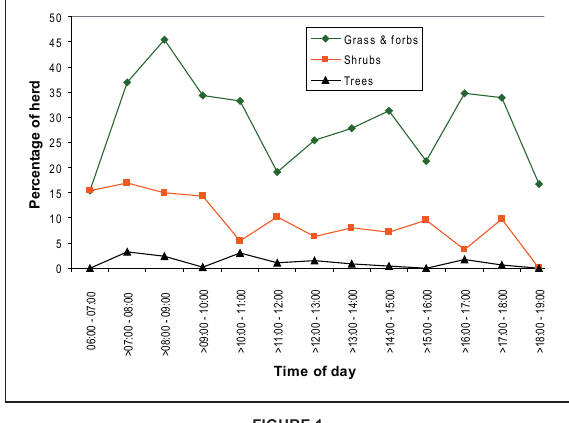
Figure 1 Mean percentage of springbok herd feeding on grass/forbs, shrubs and trees at hourly intervals from November 2002 to May 2004 in the Kalahari Gemsbok